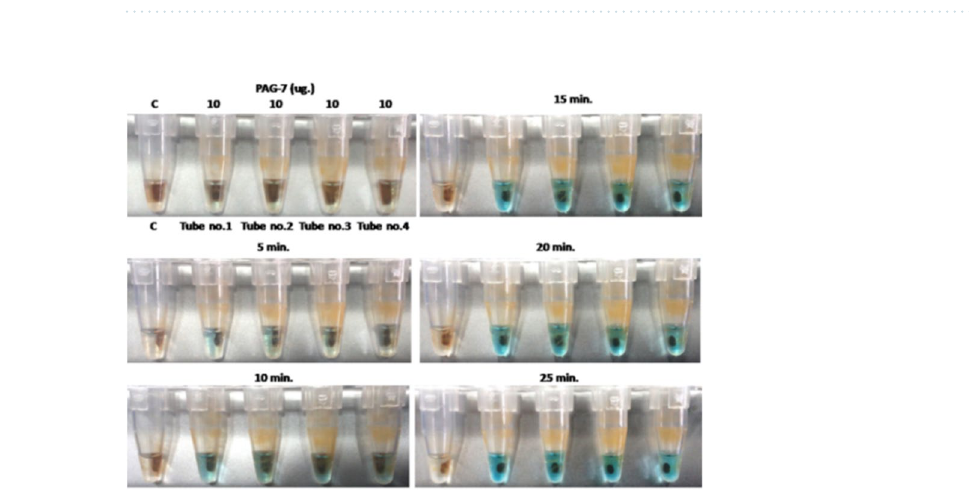
Figure 1. Diagrammatic sketch of aptamer selection.